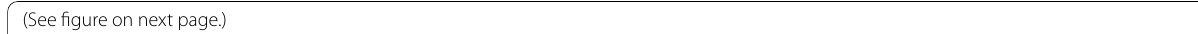
Fig. 1 NDR1 modulates apoptosis and drug sensitivity in breast cancer cells. a , b NDR1 or control vector was expressed in SUM149 cells for 24 h. Then, SUM149 cells were treated with or without Epirubicin (2.5 µM) for 48 h. Cells were harvested and subjected to Annexin V‑FITC staining, flow cytometry analysis and western blot analysis. c , d NDR1 siRNA or control siRNA were transfected in SUM149 cells for 24 h. Then, SUM149 cells were treated with or without Epirubicin (0.5 µM) for 48 h. Cells were harvested and subjected to Annexin V‑FITC staining, flow cytometry analysis and western blot analysis. e NDR1 or control vector were expressed in MCF‑7 cells for 24 h. Then, MCF‑7 cells were treated with or without Epirubicin (2.5 µM) for 48 h. Cells were harvested and subjected to Annexin V‑FITC staining and flow cytometry analysis. f NDR1 siRNA or control siRNA were transfected in MCF‑7 cells for 24 h. Then, MCF‑7 cells were treated with or without Epirubicin (0.5 µM) for 48 h. Cells were harvested and subjected to Annexin V‑FITC staining and flow cytometry analysis. g NDR1 or control vector were expressed in SUM149 cells for 24 h. Then, SUM149 cells were treated with or without Taxol (20 nM) for 48 h. Cells were harvested and subjected to Annexin V‑FITC staining and flow cytometry analysis. h NDR1 siRNA or control siRNA were transfected in SUM149 cells for 24 h. Then, SUM149 cells were treated with or without Taxol (5 nM) for 48 h. Cells were harvested and subjected to Annexin V‑FITC staining and flow cytometry analysis. The bar represents mean SD of three independent experiments ± (*: p < 0.05, **: p < 0.01, ***: p